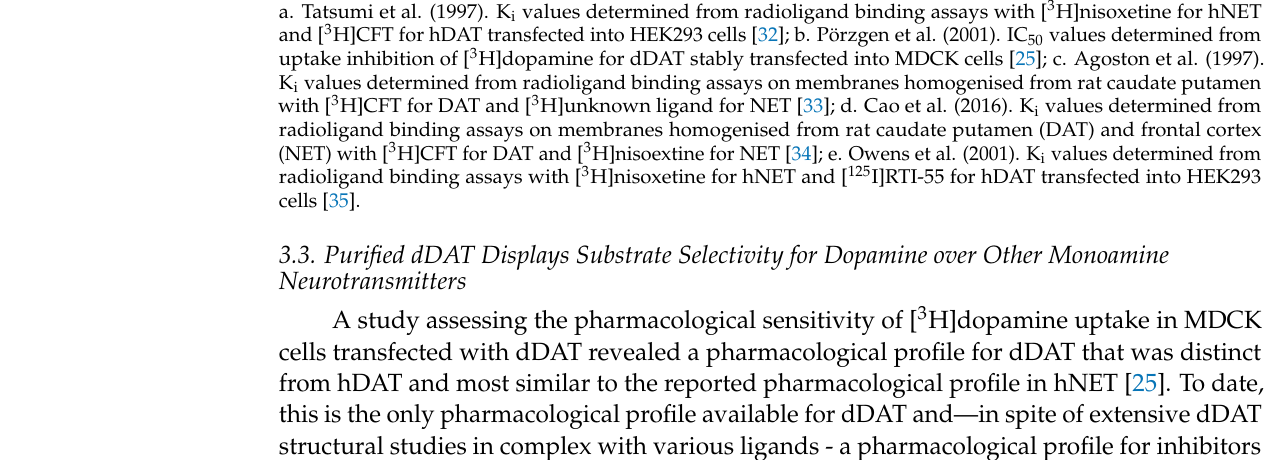
> 100000 a > 100000